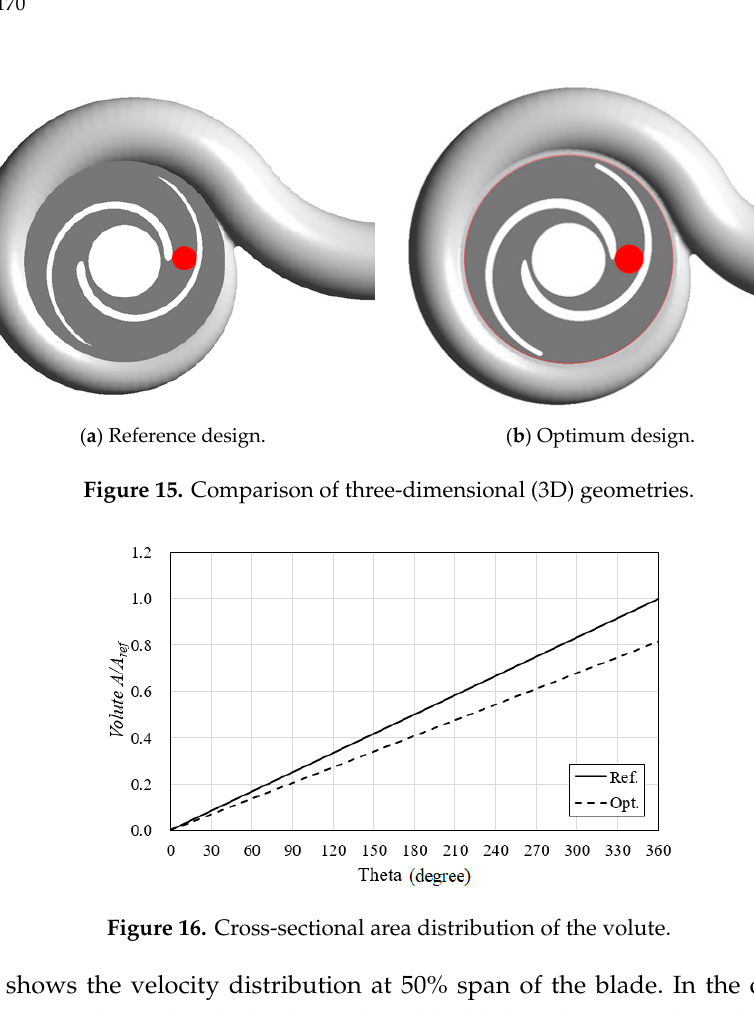
Figure 14. Flow passage area distribution in the meridional direction.